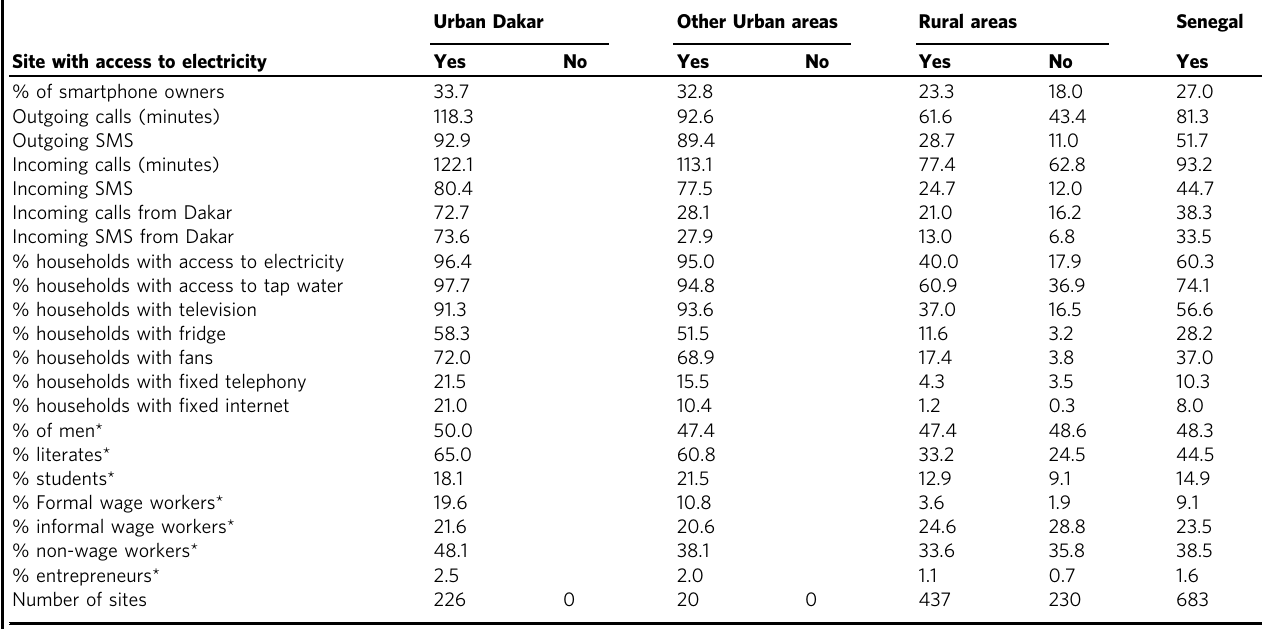
Table 1 Access to electricity and mobile connectivity-descriptive